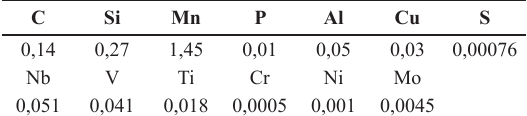
Figure 1. Mechanisms of formation of the delaminations 10 . Table 1. Chemical composition of API X 70 steel.